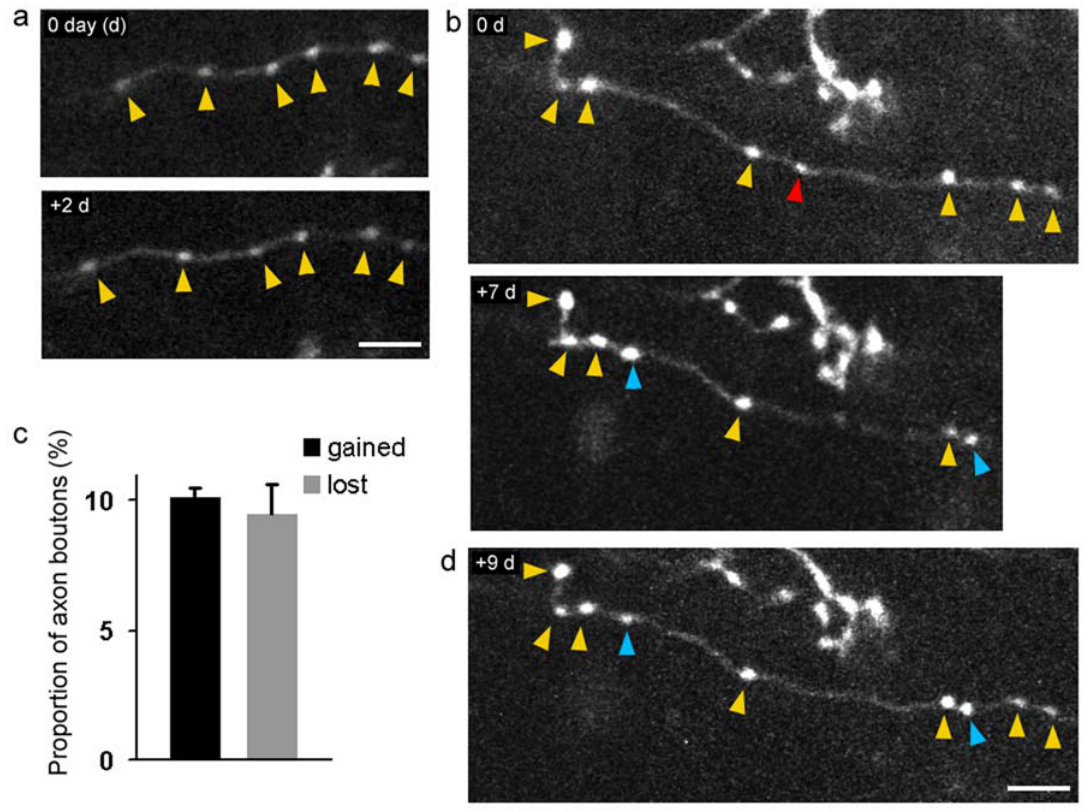
Figure 5. Chronic 2-photon imaging of structural dynamics of basket interneurons in-vivo. (a) Example images of the morphology of an axon branch and boutons in which both were stable over the course of two days. (b) One-week imaging interval in which the axon branch and boutons were largely stable (yellow arrowheads), additions (blue arrowheads) and subtractions (red arrowheads) on the axon shaft were observed. Note, two far right boutons are not shown for day 7. (c) Proportion of axon bouton additions and subtractions (total number of boutons examined=183, from three animals). (d) Example in which newly formed boutons persistented for at least two days (blue arrowheads). Scale bars: 5 m